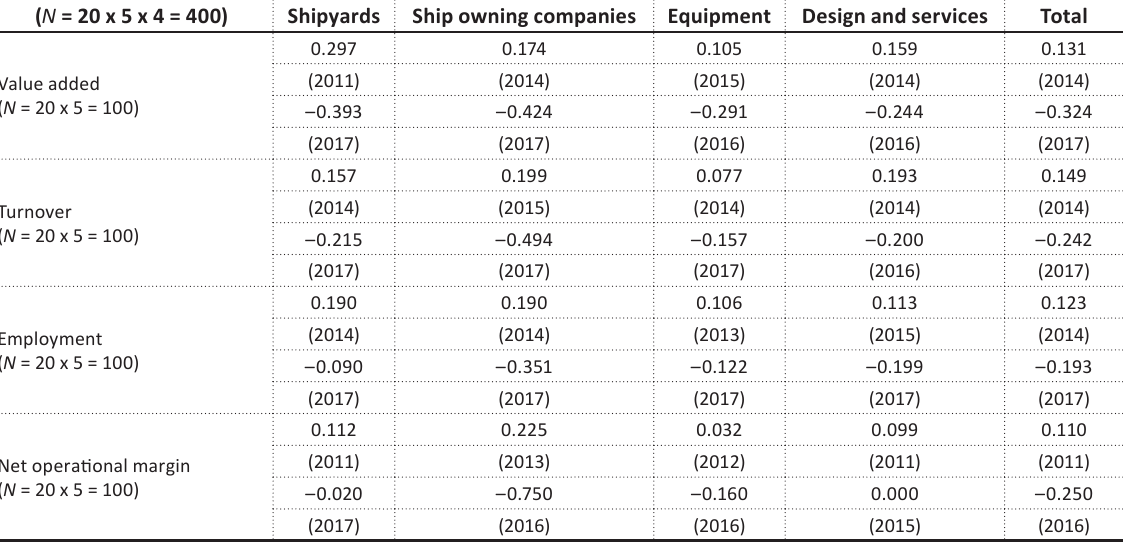
Table 2. Cycle components by industry for the BMC